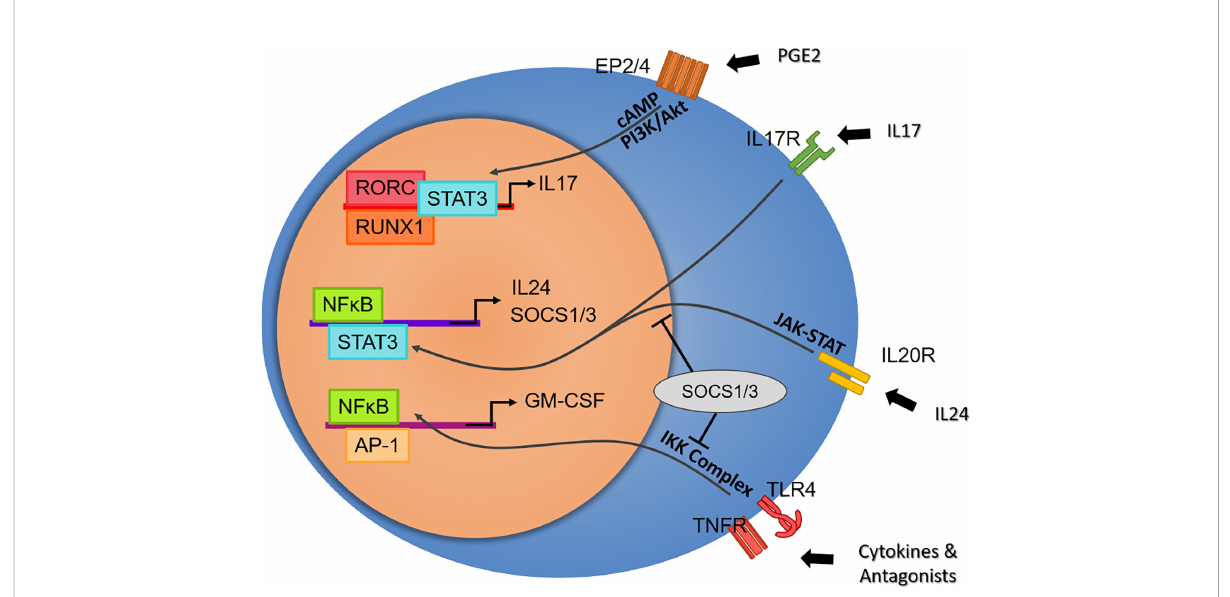
FIGURE 2 Potential effector axis of Th17 cells independent of IL-23 stimulation. From top to bottom: Prostaglandin E2 plays a critical role in ankylosing spondylitis by activating Th17 cells in an RORC-dependent pathway. Despite its multifaceted proin fl ammatory effects, IL-17 may overrepresent Th17 function. The paradoxical in fl ammation induced by the RORC blockade elicits the discovery of the intrinsic negative feedback of IL-17, where the IL-24 autocrine induced by IL-17 regulates cytokine production by SOCS1/3. In contrast, GM-CSF, a secret weapon of Th17, is not under the regulation of RORC. GM-CSF secretion by T cells or nonimmune cells may represent a protocol of the early stage in response to a broad range of tissue damage and DAMPs via TLR and TNFR signaling, as well as a particular pathogenic pathway in autoimmune